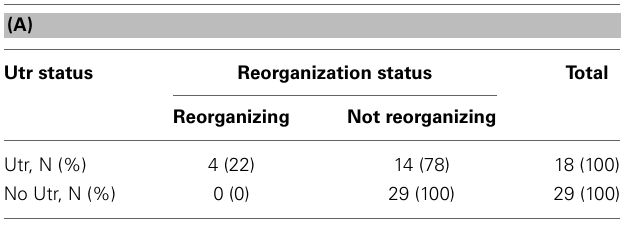
Table 3 | Infant attachment security predicted by reorganization in mothers with unresolved trauma